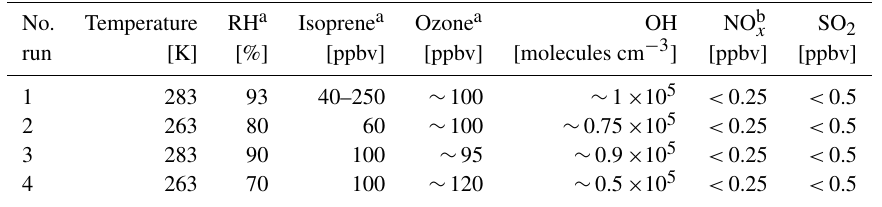
Table 1. Average experimental